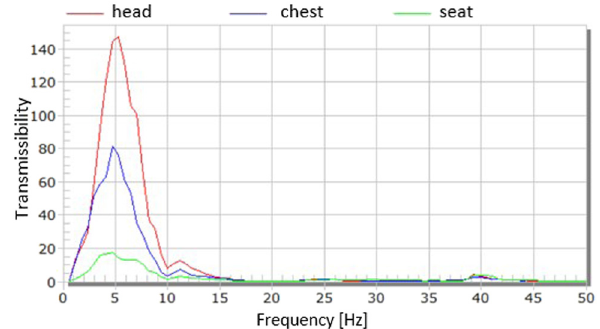
Figure 7: The range of transmissibility of the vertical vibrations of the whole body to the seat, chest, and head as a function of the frequency for the 20 Hz